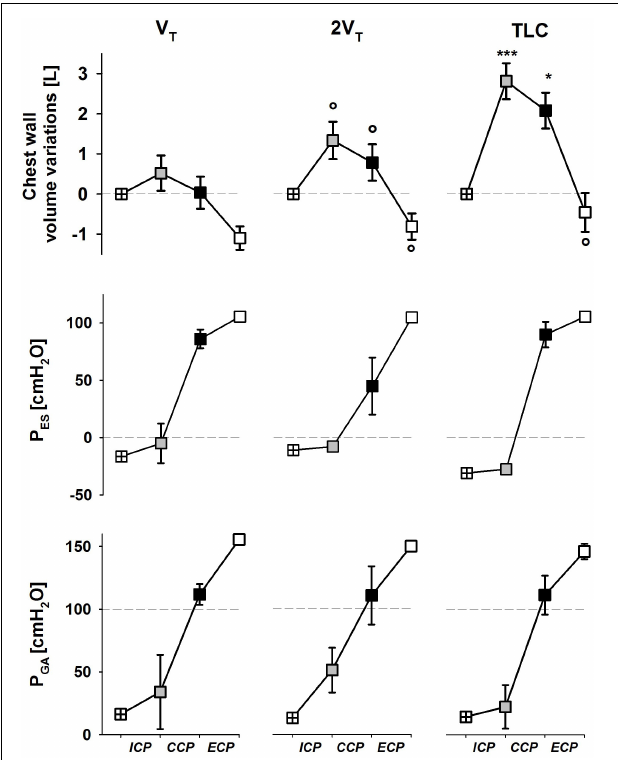
FIGURE 3 | Average values ± standard deviation of chest wall (trunk) volume (upper panels), esophageal (middle panels) and gastric (bottom panels) pressures at start inspiration (crossed symbols), end of the ICP (gray symbols), end of the CCP (black symbols), and end of the ECP (white symbols) at each operating lung volume: a tidal volume above functional residual capacity (V T , left panels), total lung capacity (TLC, right panels), and an intermediate volume (2V T , middle panels). ICP, inspiratory cough phase; CCP, compressive cough phase; ECP, expulsive cough phase. ∗ p < 0.05, ∗∗∗ p < 0.001 vs. both V ◦ p < 0.05 vs. V T and 2V T ; T .